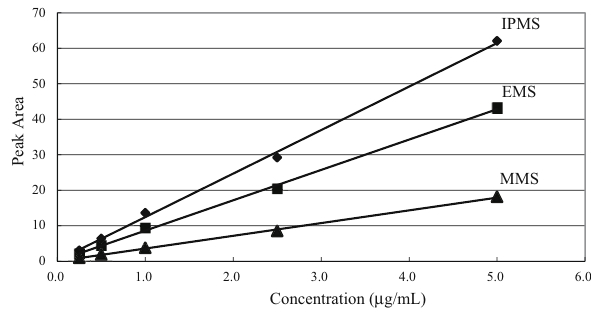
Figure 3: Linear plot for MMS, EMS, and IPMS from 0.25 to 5 µg/mL ( corresponding to 0.5 – 10 ppm in the delgocitinib drug substance ) .